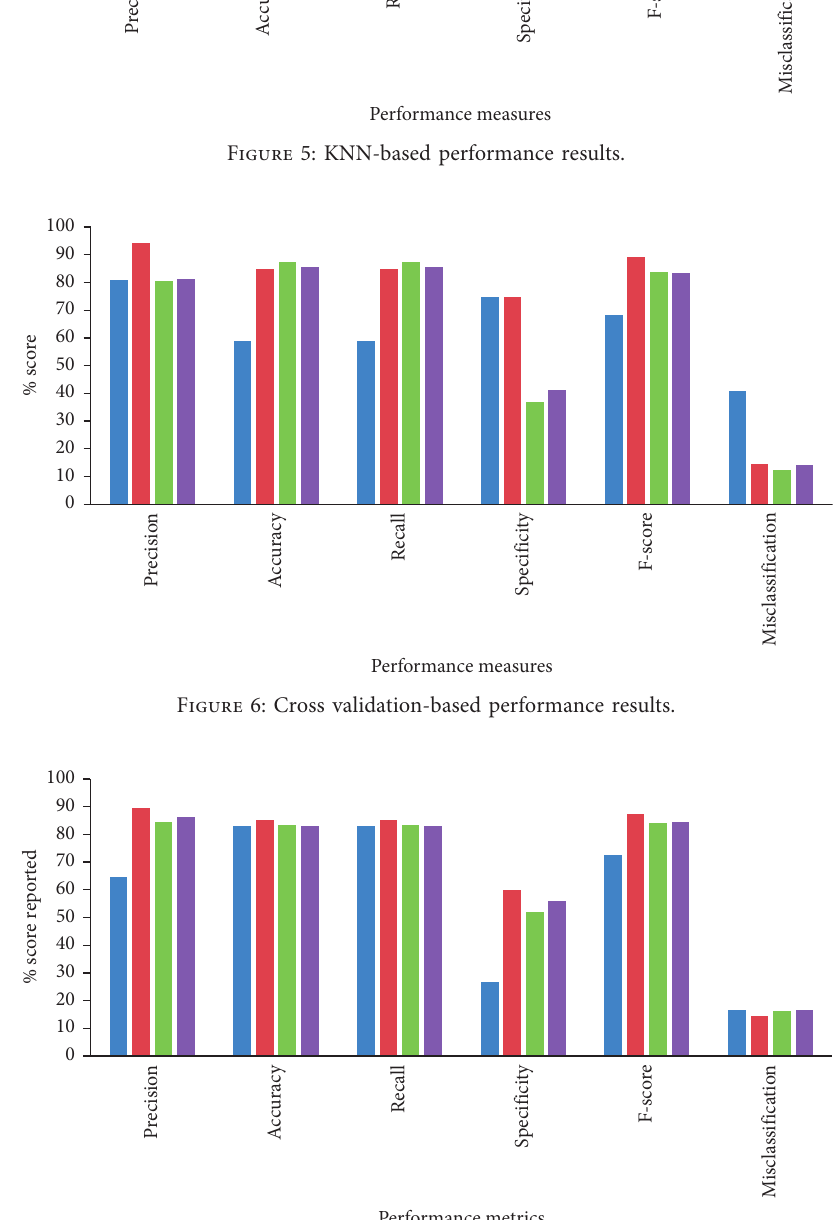
Figure 7: Decision rules-based performance